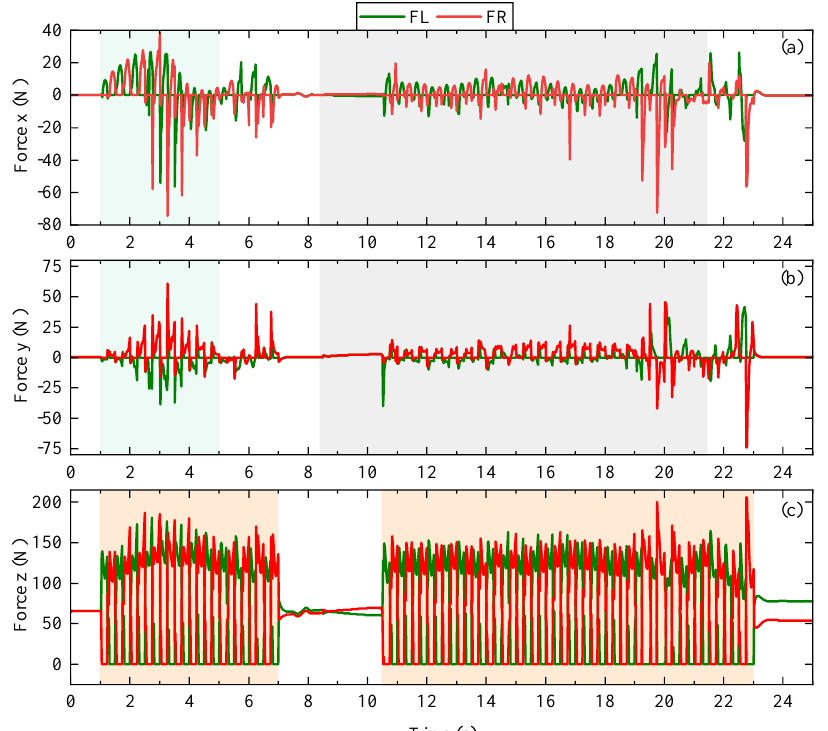
Figure 14. Ground reaction forces of the front-left and front-right feet. Graphs ( a – c ) are contact forces in x-, y- and z-direction, and these forces are expressed in the world frame. The green area indicates the process of approaching the door. The gray area indicates the time duration of opening the spring-loaded door. The orange area indicates the robot is